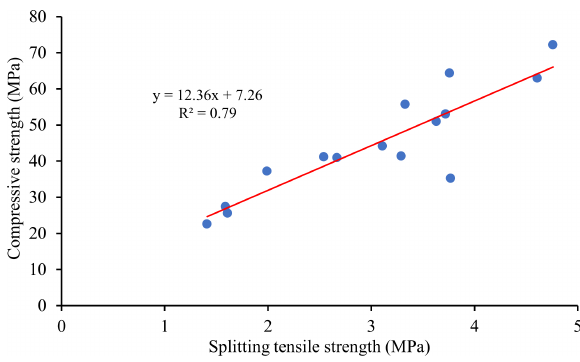
Fig. 5. Correlation of compressive strength and splitting tensile